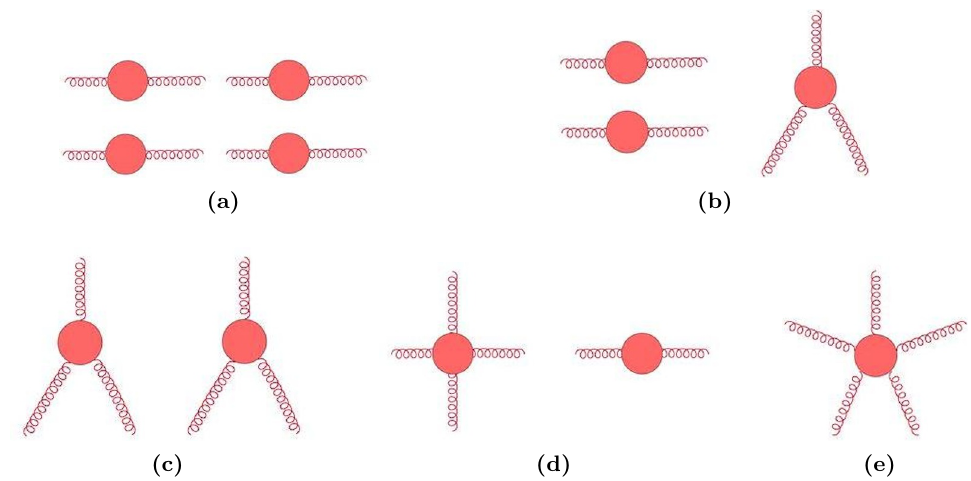
Figure 9. Combinations of connected correlators that can form Cwebs at four